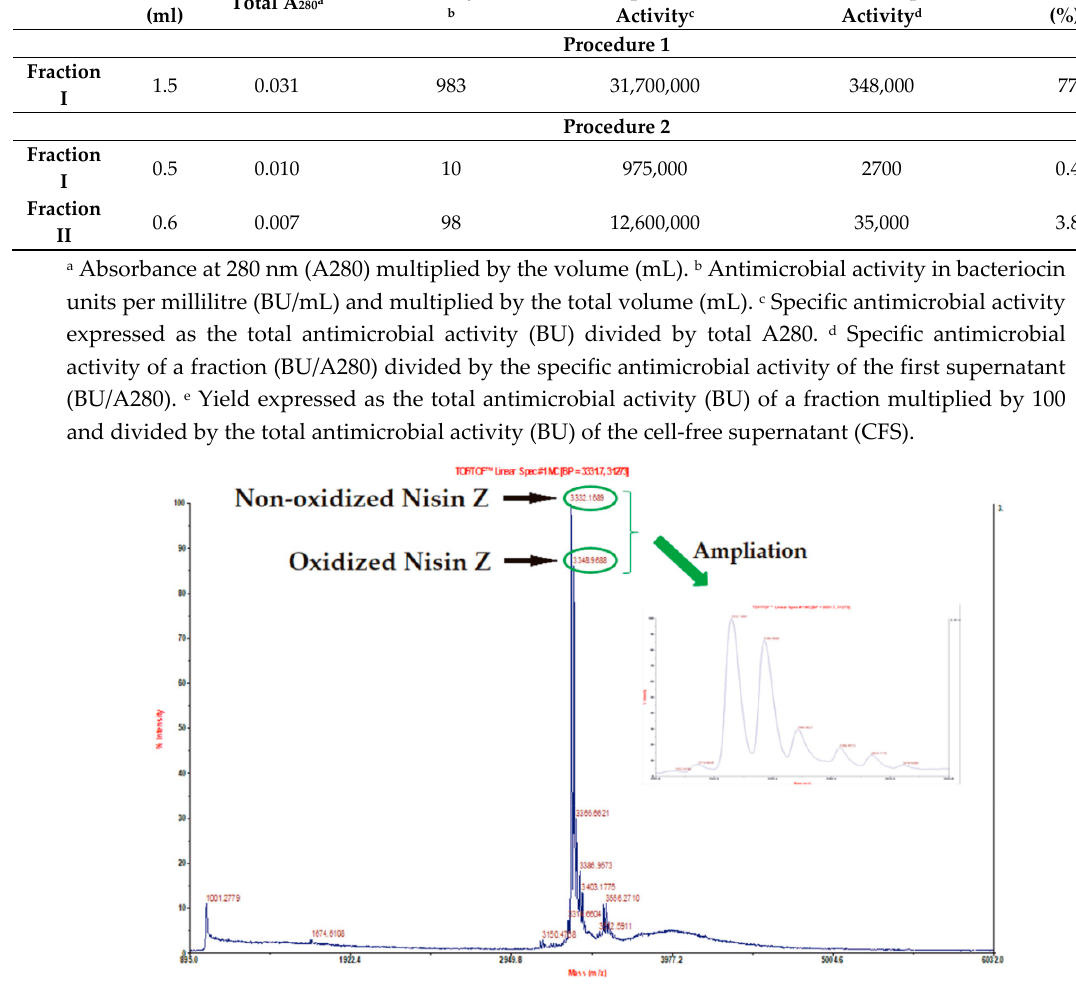
Figure 1. MALDI-TOF/TOF mass spectrometry analysis of nisin Z (NisZ) from L. lactis RBT18 purified after the final reversed phase-fast protein liquid chromatography (RP-FPLC) using the multi- chromatographic procedure